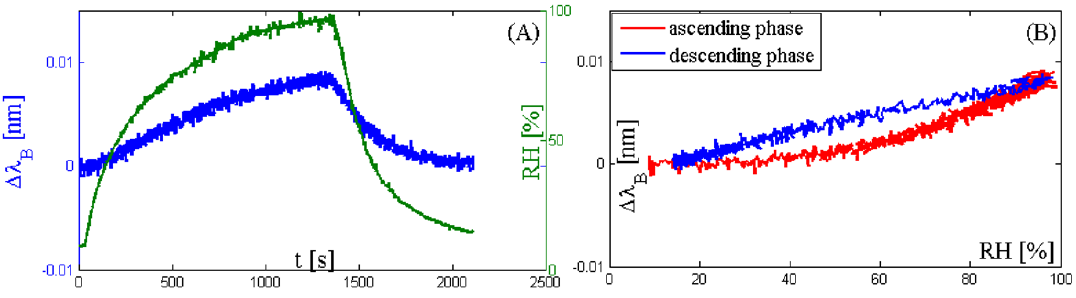
Figure 5. ( A ) RH trend during the cycle (green line) and corresponding Bragg wavelength shift of the temperature sensor (blue line); ( B ) Bragg wavelength shift of the temperature sensor output as a function of the RH values during both the ascending phase (red line) and descending phase (blue line).